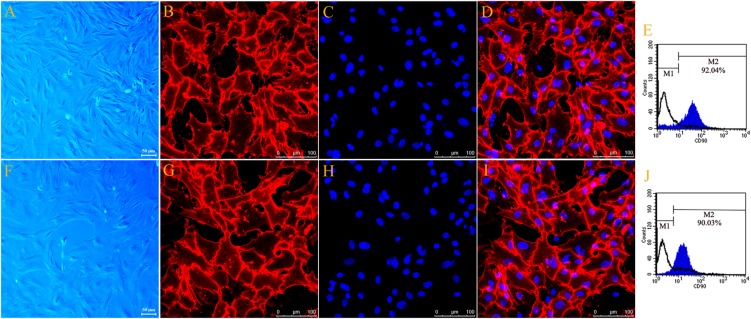
Phase-contrast micrograph showed typical cell morphology of primary cultured motor (A) and sensory Fbs (F) (scale bar, 50 μm). Fluorescence microscope photograph (scale bar, 100 μm) of cultured motor (B–D) and sensory fibroblasts (G–I) showing immunostaining with antibody against Thy-1 (B,G, green), Hoechst 33342 nucleus staining (C,H, blue), and the merge of both staining (D,I), n = 9 rats. The FCA graph showing the percentage of Thy-1-positive cells (M2) of cultured motor (E) and sensory (J) fibroblasts, n = 10 rats.